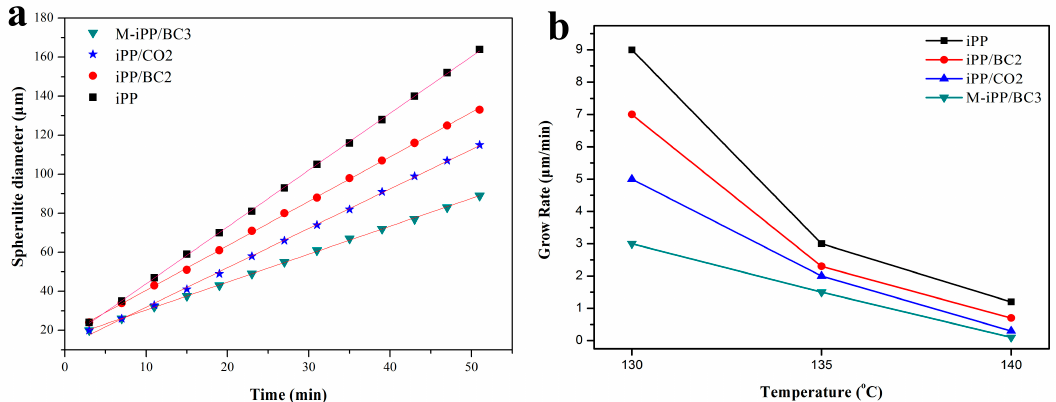
Figure 8. Effects of interface compatibility on ( a ) the changes of spherulite diameter at 135 °C and ( b ) the spherulite growth rate of the iPP/BC composites.